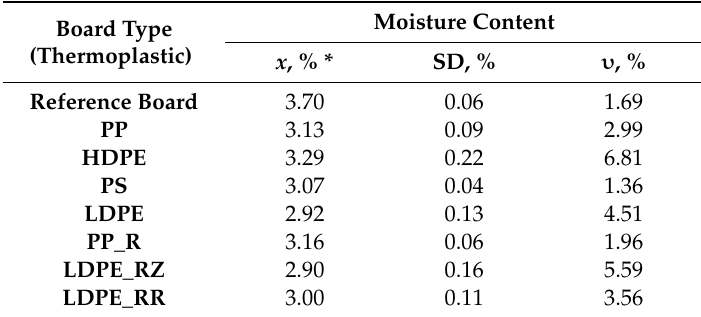
Table 2. Board moisture content after